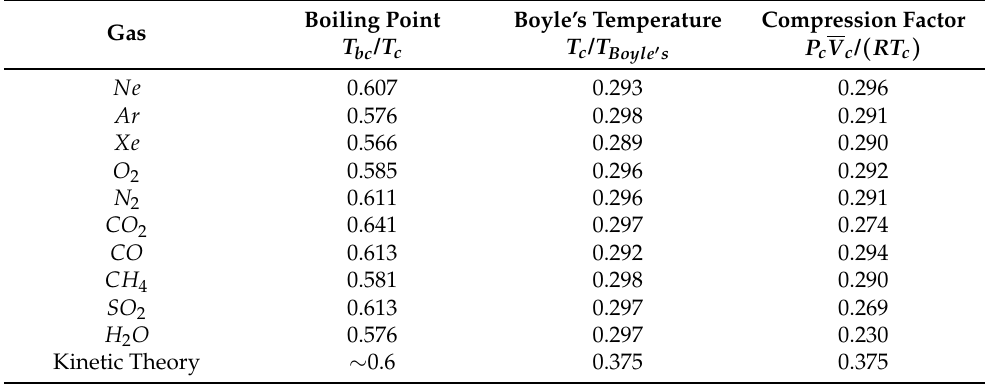
Table 1. Normalized thermodynamic properties of simple gases at standard temperature (273.15 K) and pressure (1